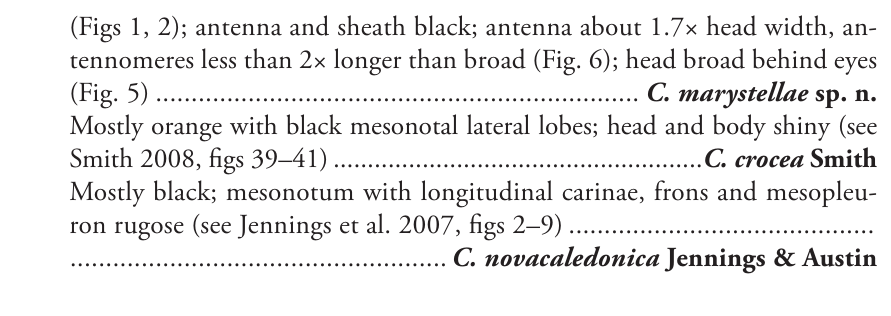
Description. Female: Length, 7.0 mm. Black; head with yellow spots between antenna and eye and between antennae (Fig. 4). Thorax black. Legs black with tibiae and tarsi pale yellow. Abdomen black with lateral white spots on first tergite (Figs 1, 2). Wings hyaline, veins and stigma black. Head : Antenna (Fig. 6) with 17 antennomeres, 1.7× head width; lengths of scape, pedicel, and first flagellomere as 1.0:0.5:0.8; flagellomeres less than 2× longer than broad. Frons, interocellar area, and area just above ocelli rugose; vertex and gena shiny, almost impunctate; few punctures on lower gena and few indistinct carinae at center of gena. Lower interocular distance subequal to eye height, in front view, eyes very slightly diverging below (Fig. 4). In dorsal view, head broad behind eyes, distance behind eyes less than 2× eye length (Fig. 5). Labial palpus with 4 palpomeres, maxillary palpus with 7 palpomeres. Thorax : Propleuron with fine longitudinal carinae dorsally, shiny laterally. Pronotum shiny with central area of fine carinae. Mesonotum (Fig. 3) with shallow notauli, with closely set pits; anteromedian part of mesonotum with fine longitudinal carina on posterior half, more finely rugose centrally and anteriorly; lateral lobes with fine longitudinal carinae on inner halves, shiny on lateral halves; axillae with longitudinal carinae; mesoscutellum finely rugose. Mesepisternum rugose, with narrow stripe along anterior margin shiny, impunctate; mesepimeron with cross carinae; meta- pleuron rugose (Fig. 2). Hind tarsal claw with small inner tooth near base, fore and mid tarsal claws with long inner tooth, more than half length of outer tooth, near center. Hind basitarsus subequal in length to remaining tarsomeres combined. Abdomen : Shiny with very fine microsculpture; tergum 1 duller, with denser microsculpture than rest of abdomen. Tergum 1 subequal in length to tergum 2. Sheath to basal plates as 1.0:1.8. Male: